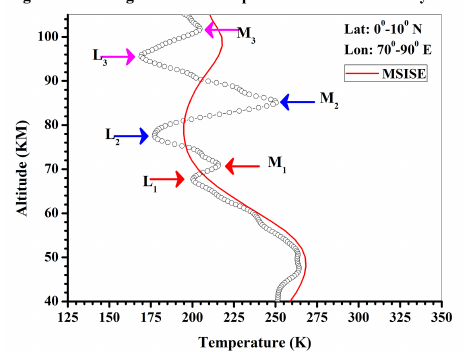
Figure 1. A sample middle atmospheric temperature profile ob- tained by SABER measurements averaged for a grid corresponding to 0–10 ◦ N and 70–90 ◦ E. The measurements are shown as open circles while the MSISE00 model estimates are plotted as a red line. The L i and M i correspond to the altitudes of lower and maxi- mum temperature for the evident i th structure in the data. Note the occurrence of minimum temperature at L 3 which is taken as the mesopause